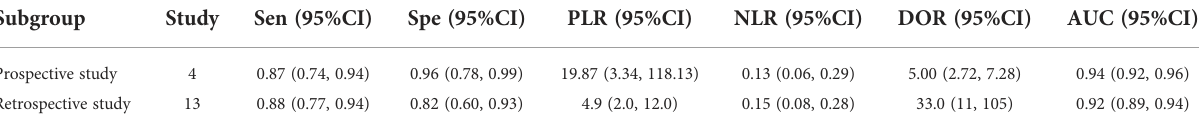
TABLE 2 Summary estimated of diagnostic performance of 18 F-FDG PET/CT for epithelial ovarian cancer based on design type.